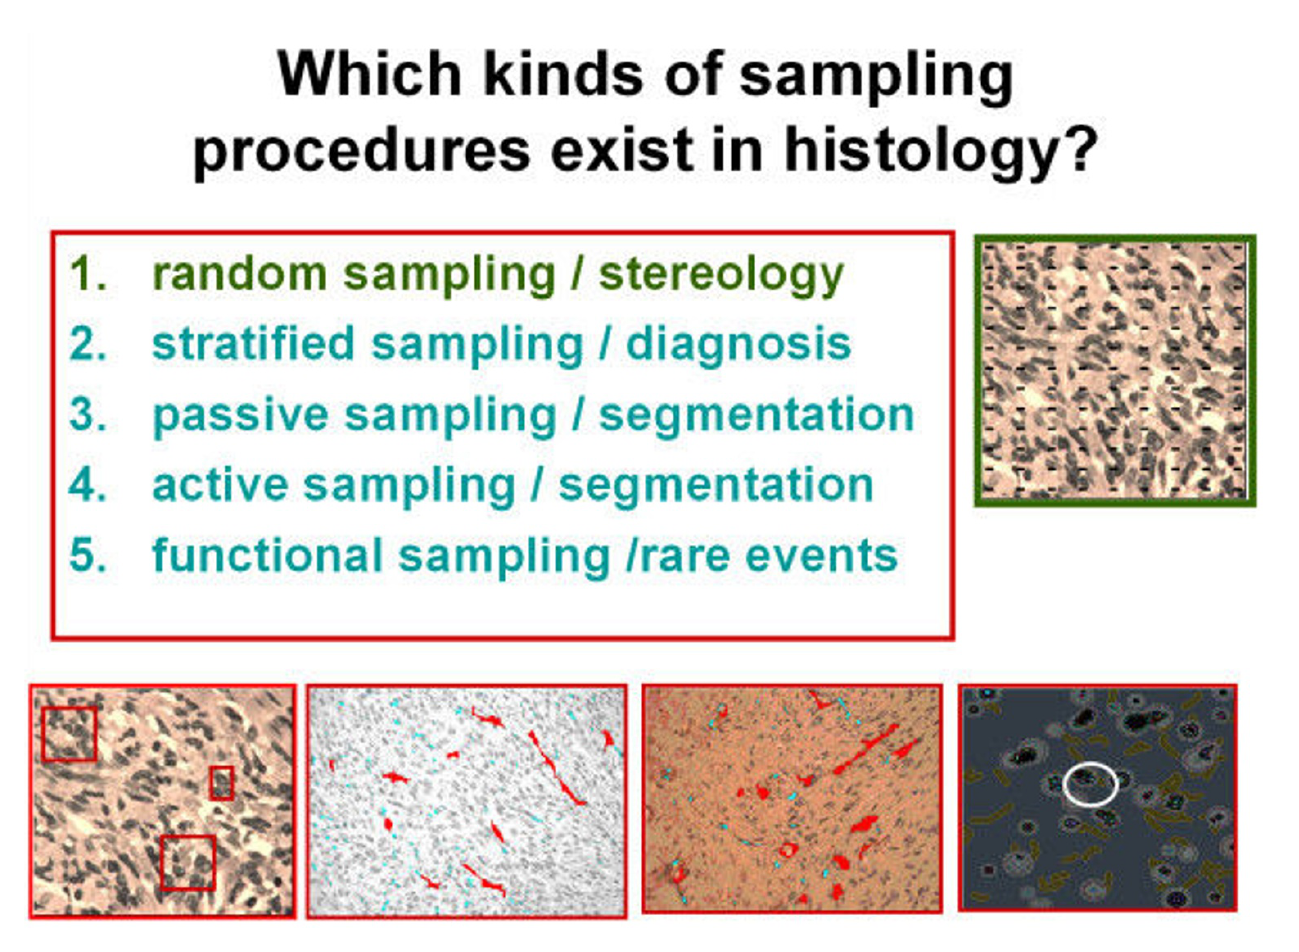
Survey of different sampling procedures Figure 6